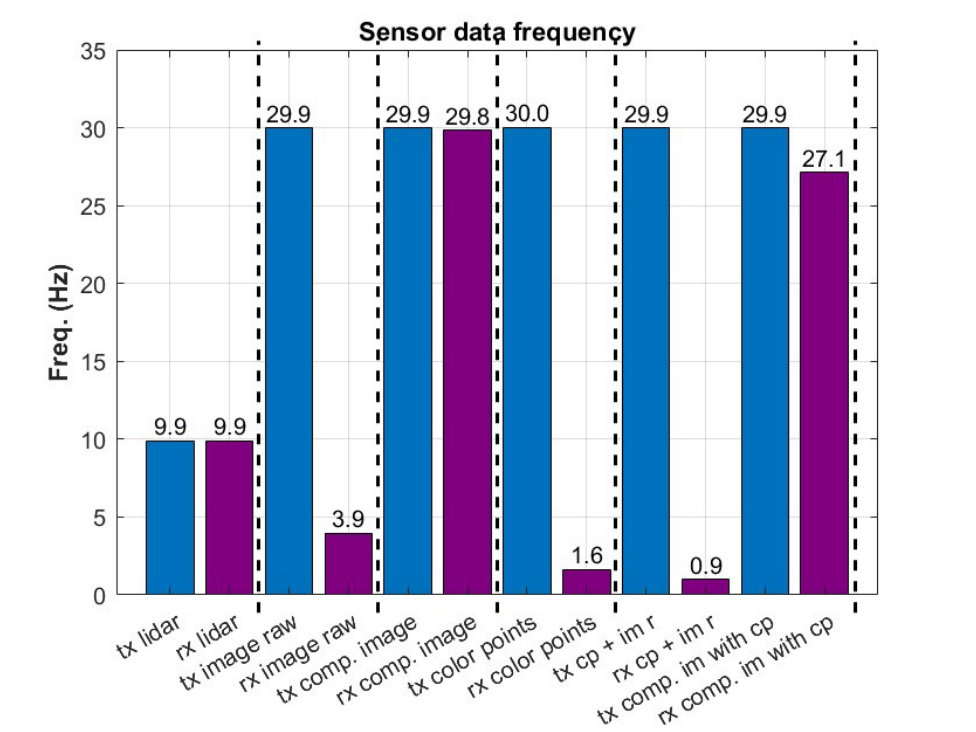
Figure 4. UAV frequency of offloaded